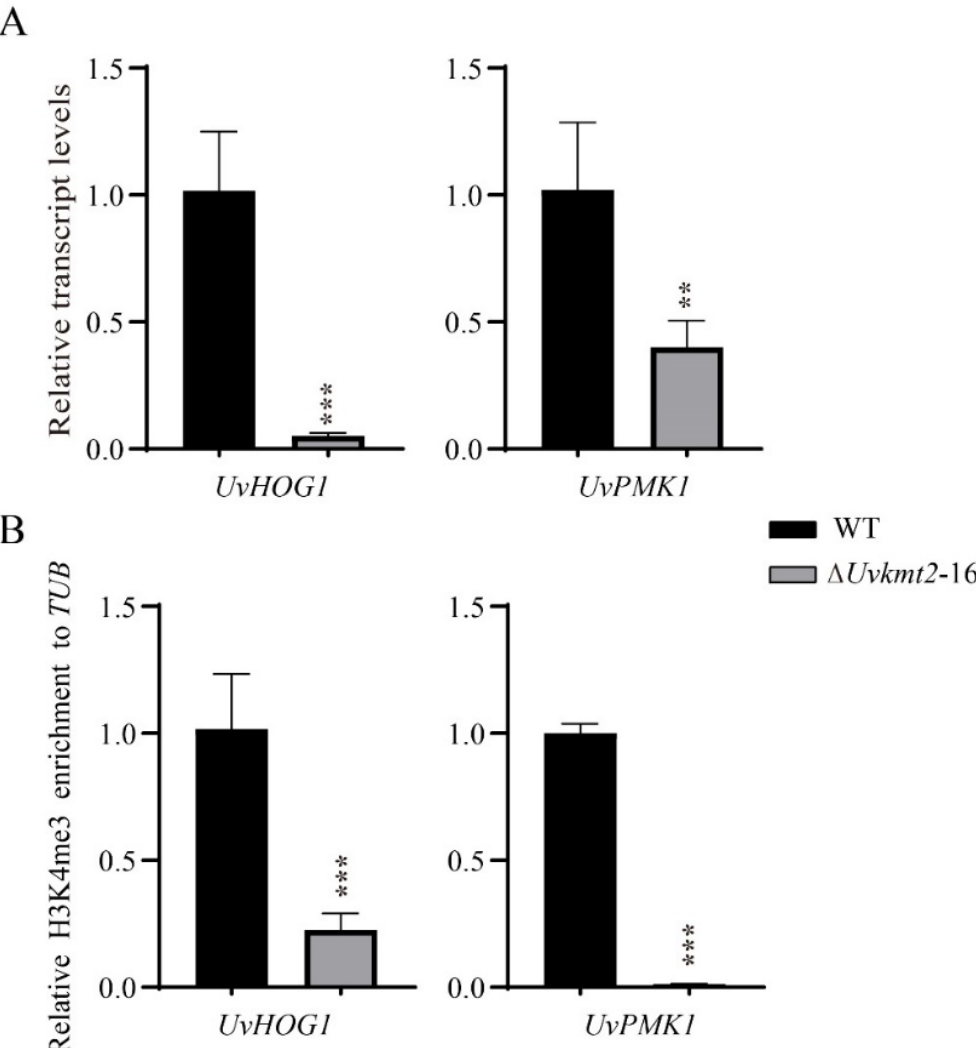
Figure 7. UvKmt2-mediated H3K4me3 modification regulates the transcription of UvHOG1 and UvPMK1 in U. virens . qRT-PCR ( A ) and ChIP-qPCR ( B ) assays of UvHOG1 and UvPMK1 genes. DNA immunoprecipitation with anti-H3K27me3 antibody was used as template to detect UvHOG1 and UvPMK1 genes enrichment in the WT and ∆ Uvkmt2 strains. Data represent mean ± SD of three independent biological replicates. Duncan’s test and the significant differences were indicated by asterisks (**, p < 0.005; ***, p < 0.001).